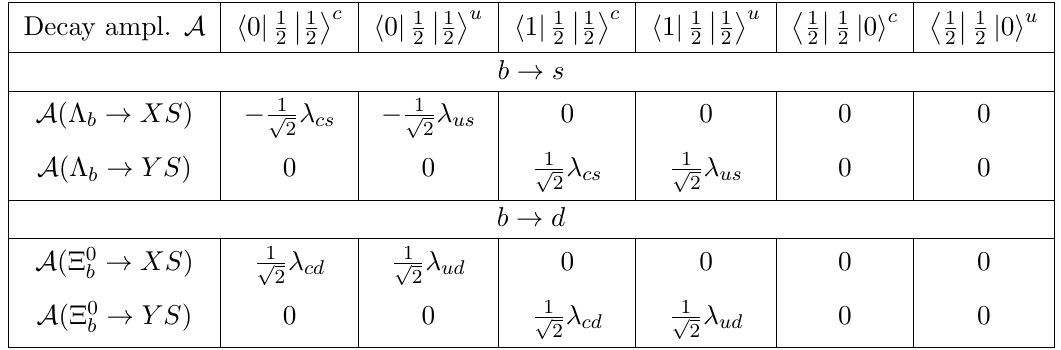
Table 6. (Unpractical) U-spin decomposition for the U-spin eigenstates j X i and j Y i , see eq. (2.34) and discussion in the